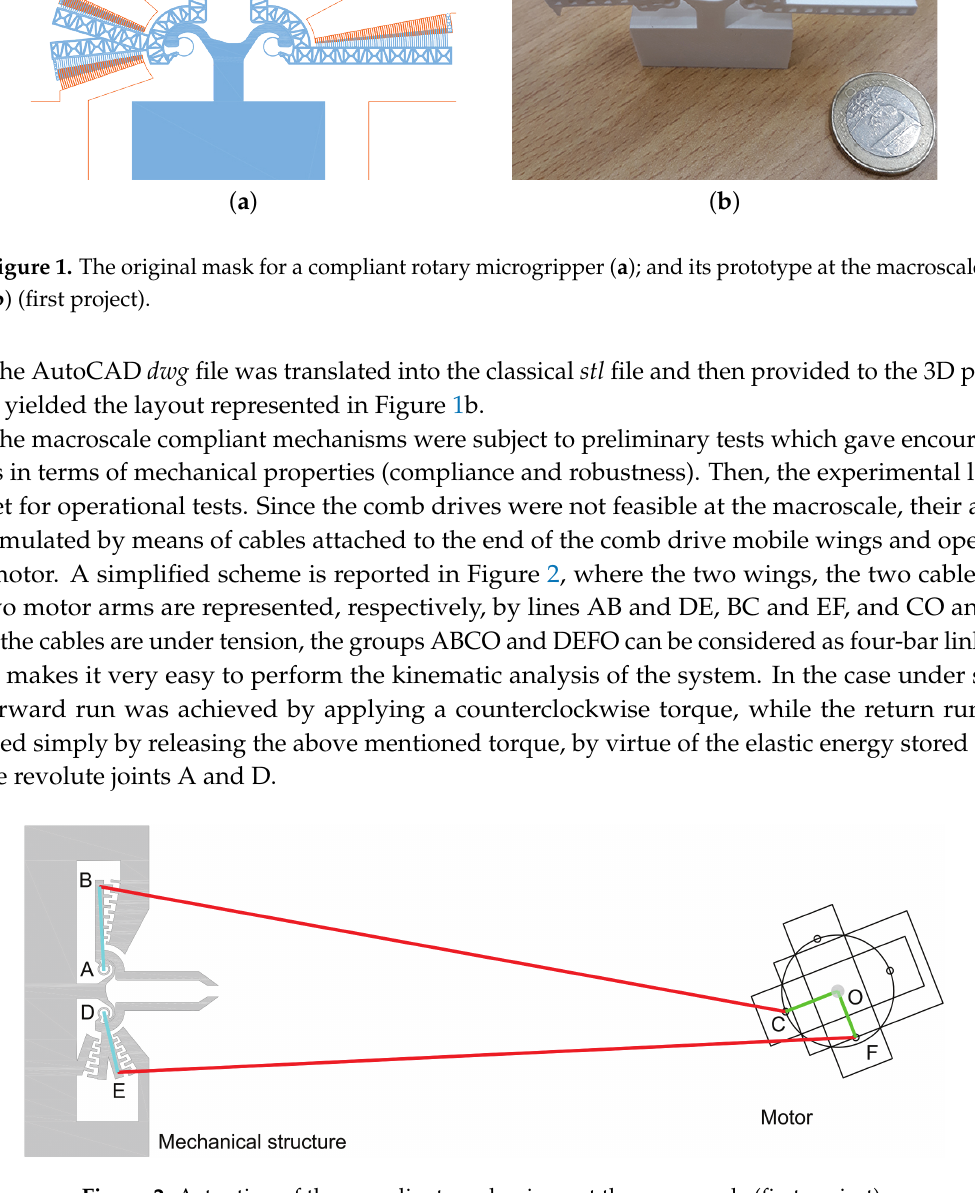
Figure 2. Actuation of the compliant mechanisms at the macroscale (first